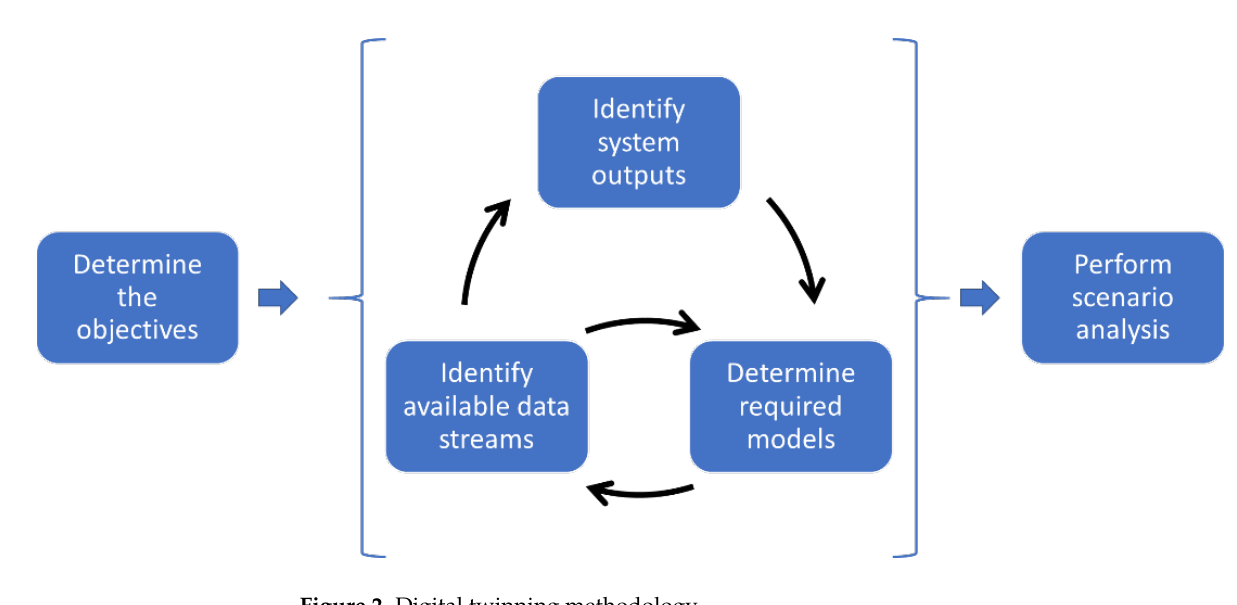
Figure 2. Digital twinning methodology.